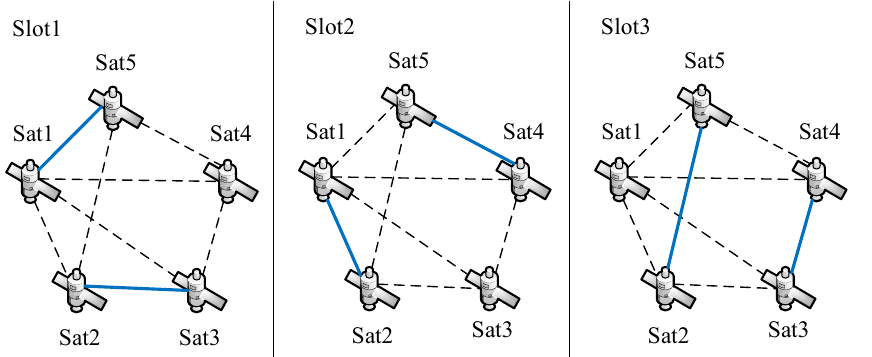
Figure 2. BeiDou-satellite global short-message communication principle.